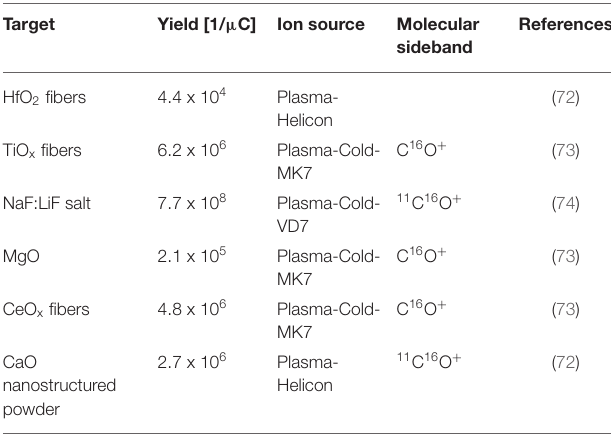
TABLE 1 | 11 C beams produced at